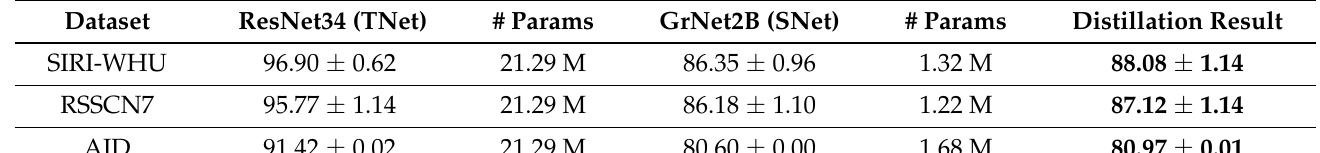
Table 4. The accuracy on SIRI-WHU, RSSCN7 and AID datasets.